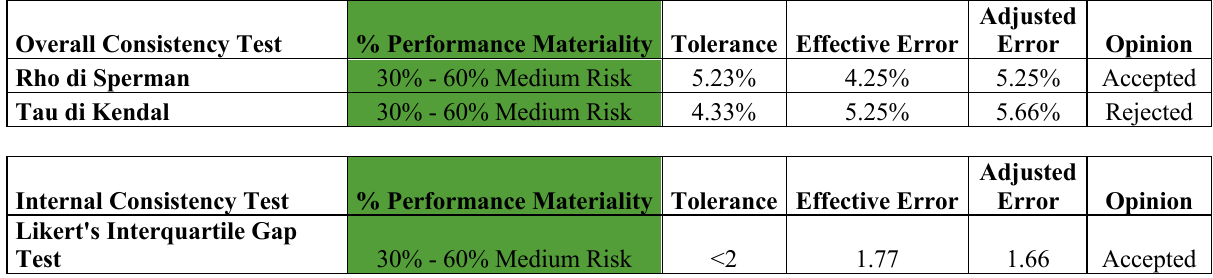
Table 6. Capability Overall Conclusion of Policy Investigations